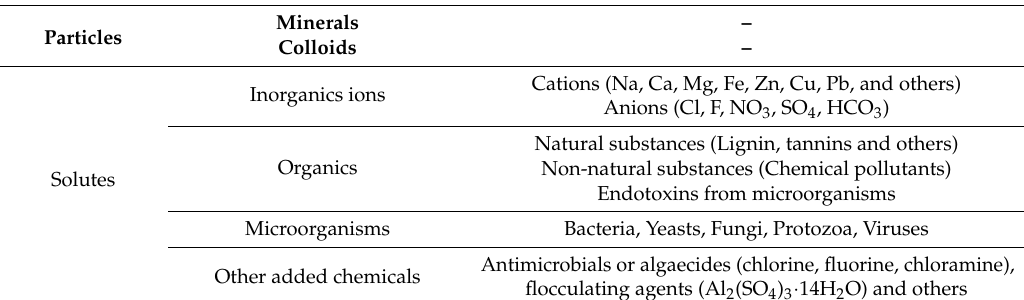
Table 1. Main water pollutants classified into particles and solutes.